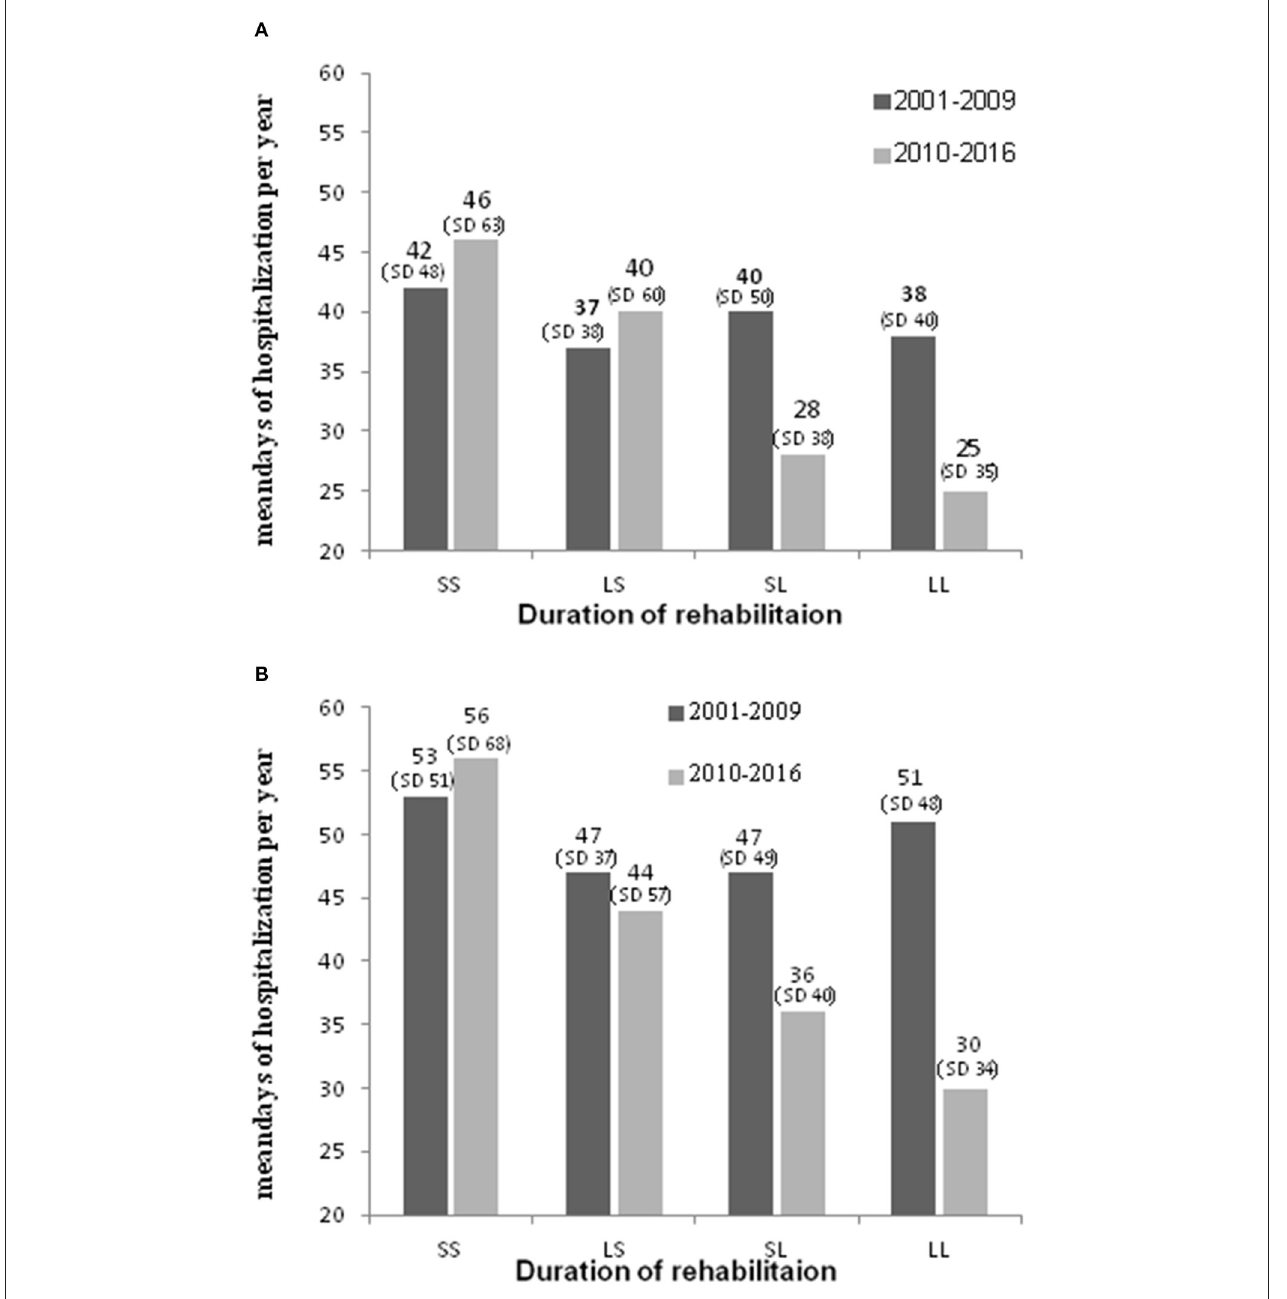
FIGURE 4 | Mean psychiatric hospitalization days per year, by duration of vocational rehabilitation in Period 1 (2001–2009) and Period 2 (2010–2016), among hospitalized persons with chronic psychotic disorder without co-occurring SUD (A) and with SUD (B) who received any vocational rehabilitation, Israel, 2010–2016. (A) Hospitalized persons with chronic psychotic disorder without SUD. (B) Hospitalized persons with chronic psychotic disorder with SUD. SS, short rehabilitation in Period 1 and Period 2 ; LS, long rehabilitation in Period 1 & short in Period 2 ; SL, short rehabilitation in Period 1 & long in Period; LL, long rehabilitation in Period 1 and